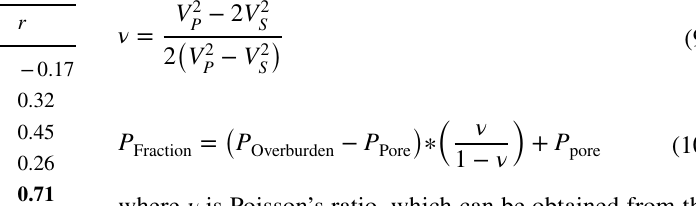
Table 6 Parameters and correlation coefficients (r) of final Effective Pressure and Compressional Velocity cubes for updated Bowers rela- tions in different formations of the studied field